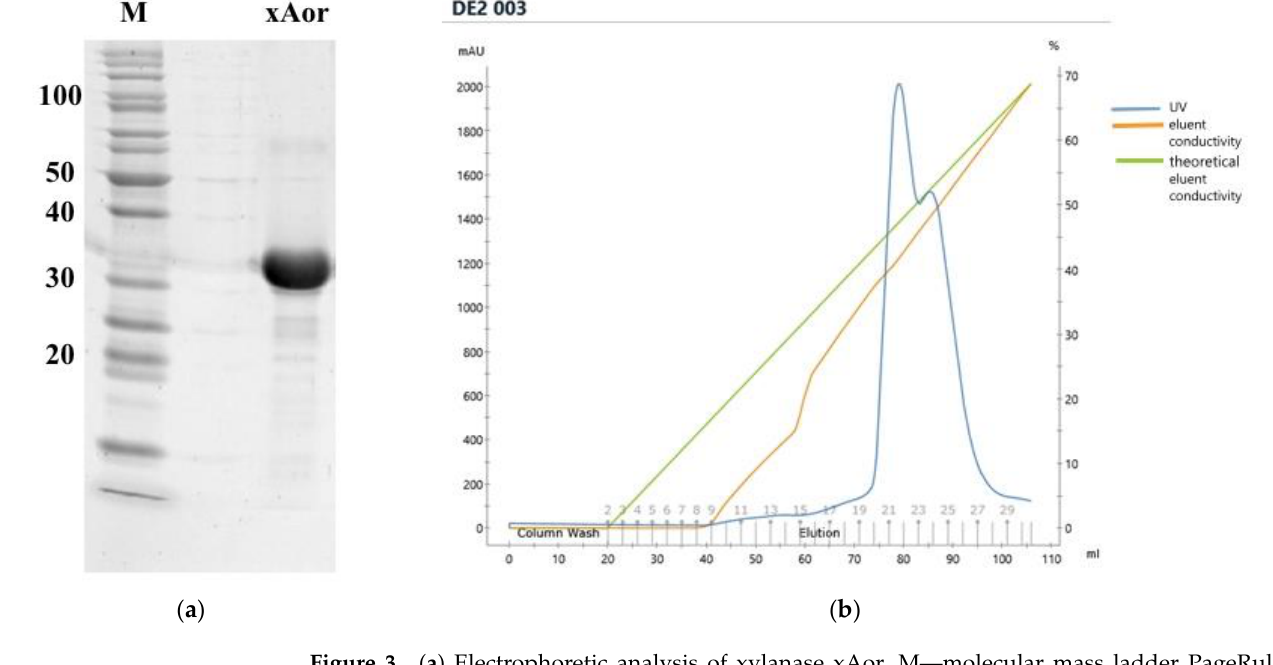
Figure 3. ( a ) Electrophoretic analysis of xylanase xAor, М— molecular mass ladder PageRuler Un- stained Protein Ladder (ThermoScientific, Waltham, MA, USA). ( b ) Chromatographic purification of xylanase xAor, performed with anionite DEAE-Sepharose 6HF (Biotoolomics, Great Britain). PS (protein score) was shown to be 1492, which is statistically significant result. MS sequence coverage was 63% (Figure 4). To determine the protein, SwissProt database was used [11].